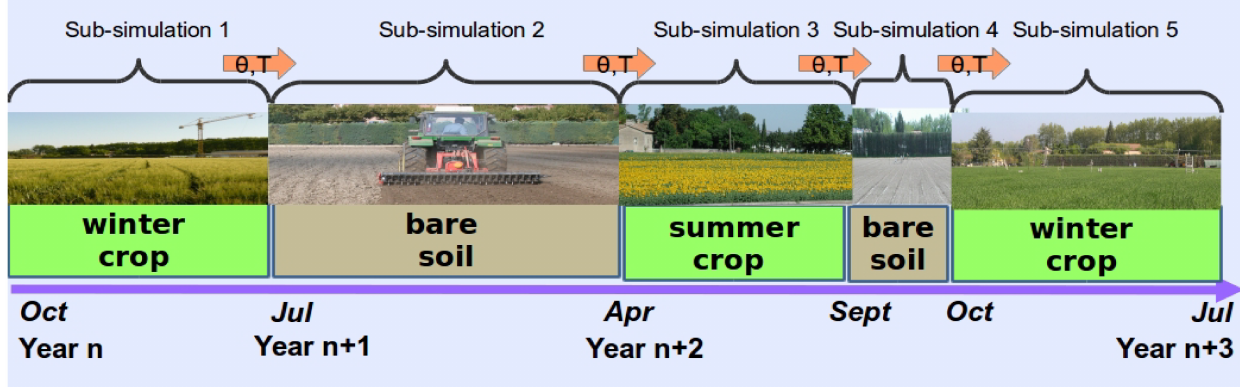
Figure 2. Illustration of the typical succession of winter and summer crop over the Avignon site and implementation of the crop succession in the simulations. θ and T represent soil moisture and soil temperature transmitted from one sub-simulation to the following